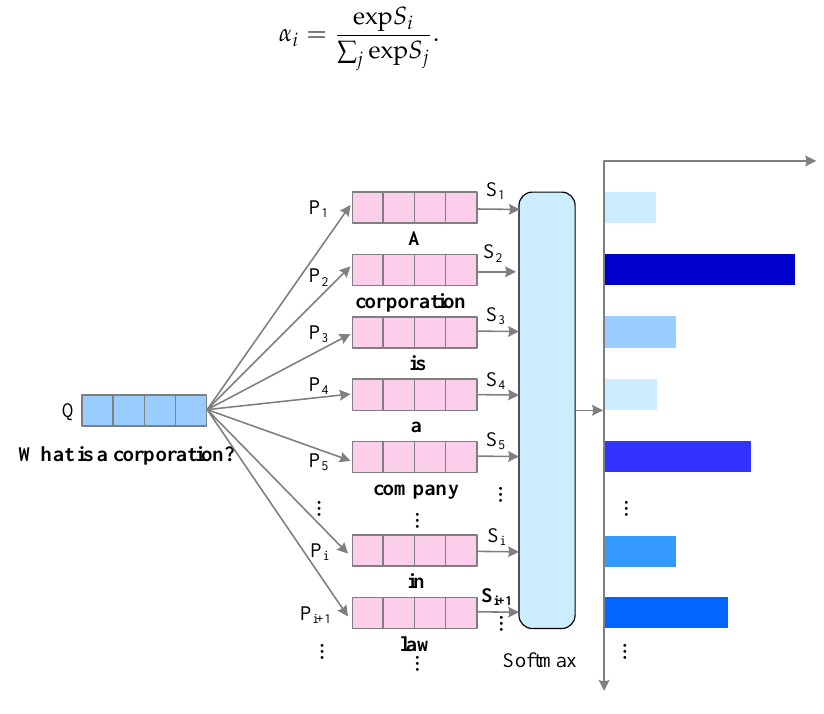
Figure 11. Using unidirectional attention to mine correlation between the context and question. The choice of function f ( · ) differs in different